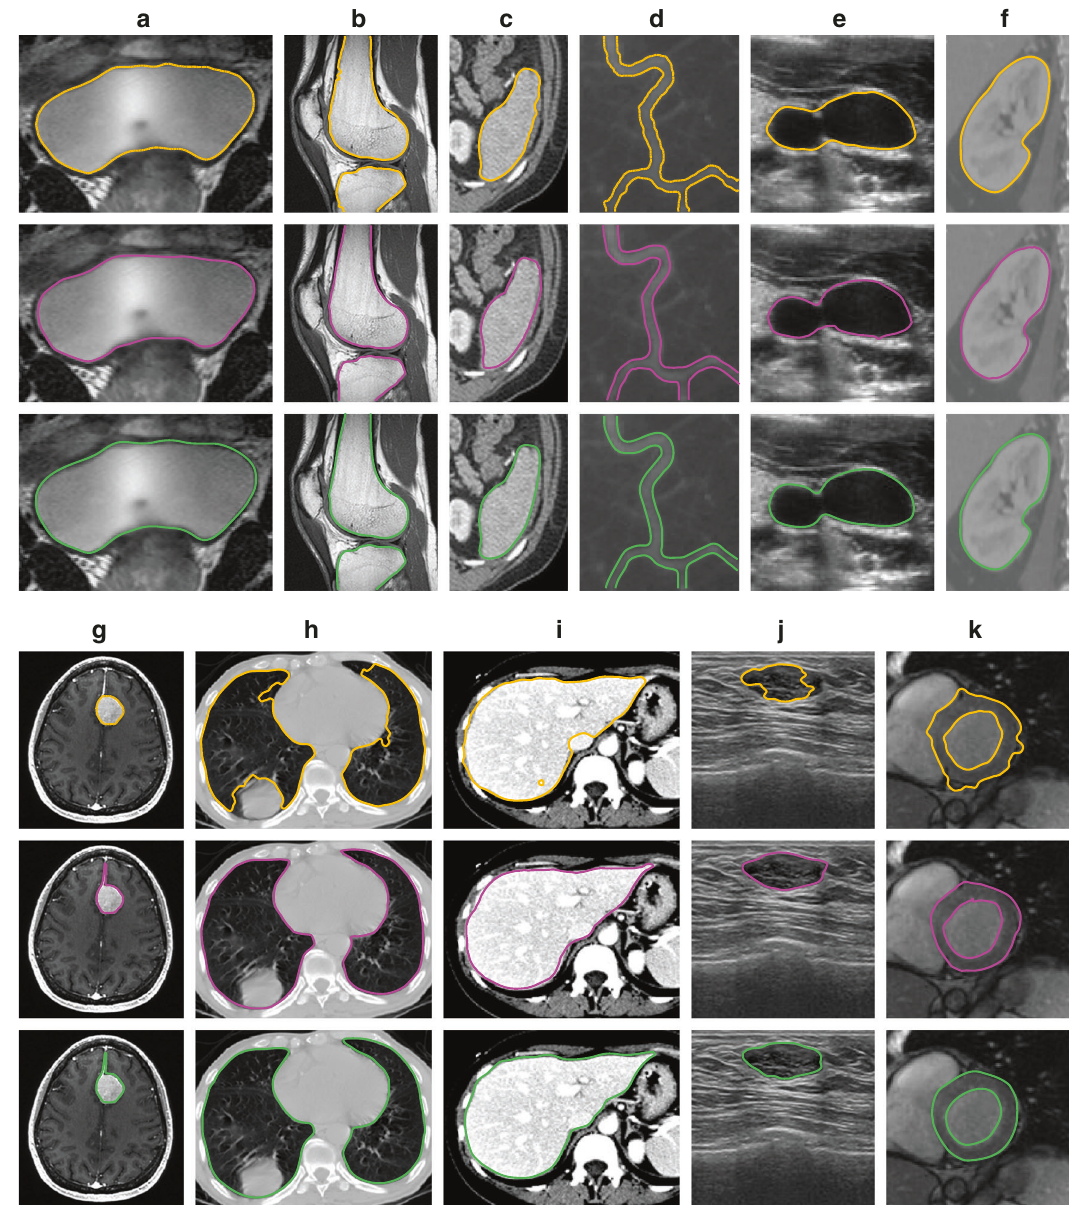
Fig. 5 Medical image segmentation results. a – k Magnetic resonance (MR) image of bladder, MR image of knee (reproduced with permission from ref. 29 ), computed tomography (CT) image of spleen (reproduced with permission from ref. 30 ), X-ray image of blood vessel (reproduced with permission from ref. 28 ), ultrasound image of blood vessel caliber, CT image of the kidney (reproduced with permission from ref. 31 ), MR image of brain tumor, CT image of lungs (reproduced with permission from ref. 34 ), CT image of the liver (reproduced with permission from ref. 35 ), ultrasound image of breast tumor (reproduced with permission from ref. 36 ), and MR image of the left ventricle. Yellow curves denote the boundaries obtained by the level-set algorithm, magenta curves represent the fi nal contours obtained by the crack-propagation method, and green curves denote the manual segmentation